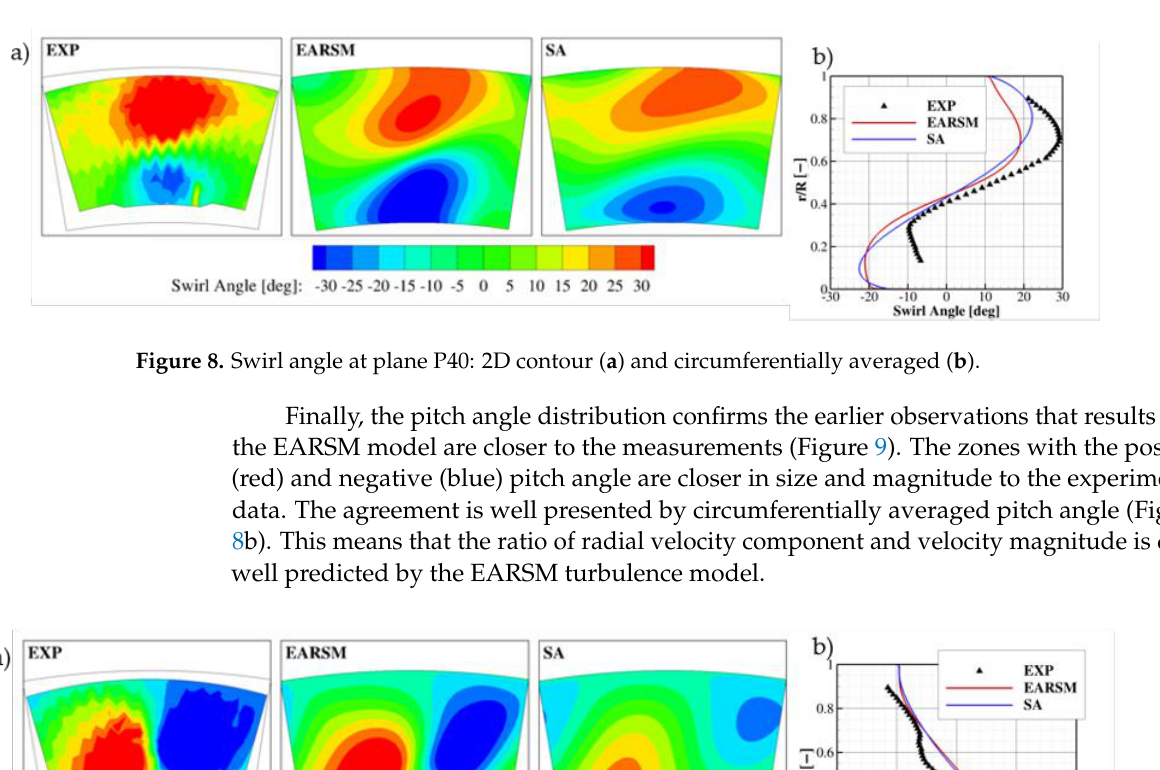
Figure 7. Non-dimensional total temperature at plane P40: 2D contour ( a ) and circumferentially averaged ( b ).